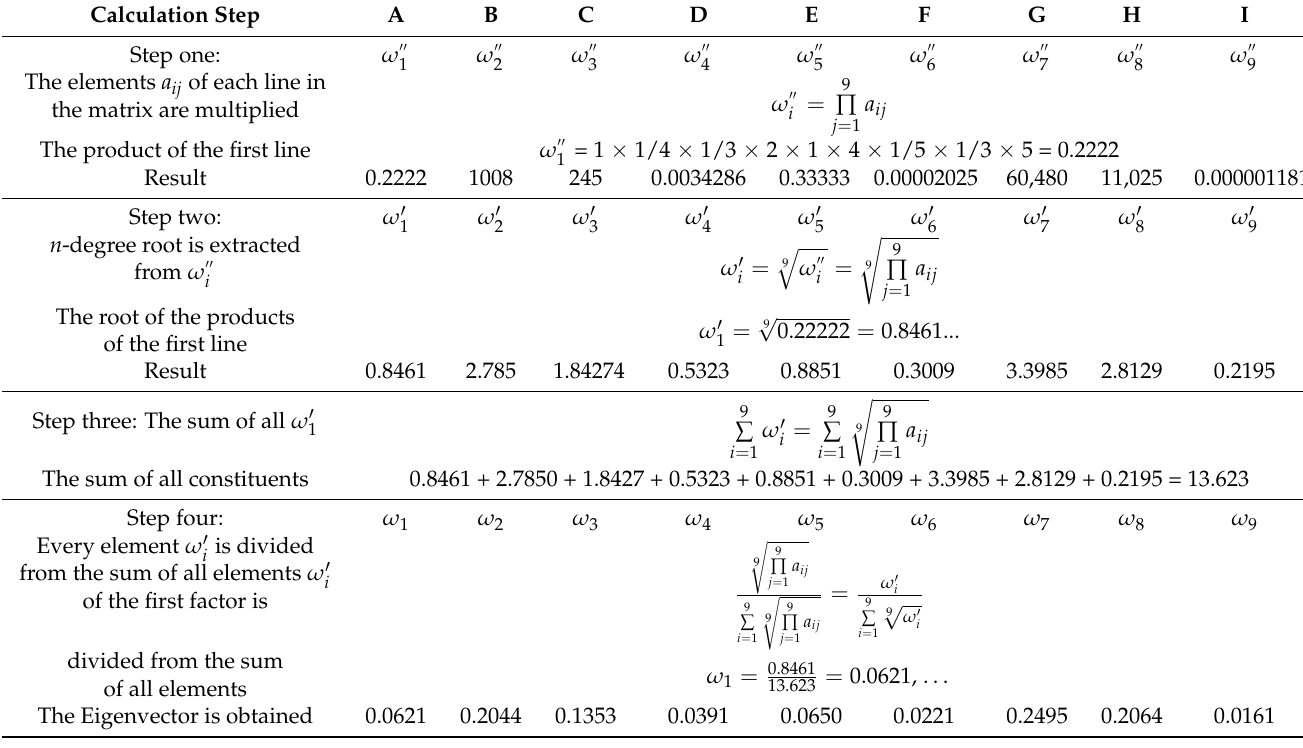
Table 5. The sequence (algorithm) of calculating the weight cause (criterion)